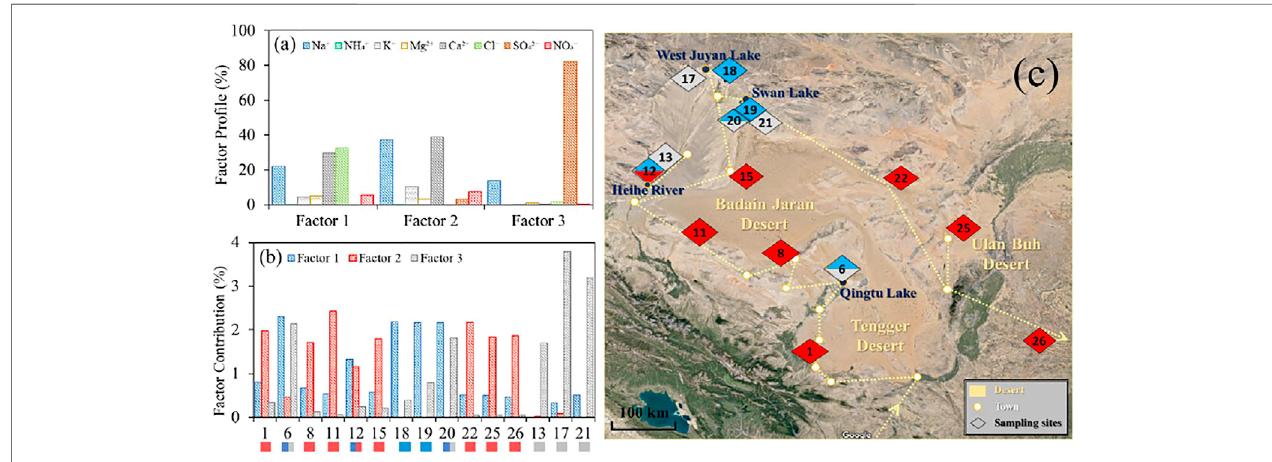
FIGURE 6 | PMF 3-factor solution based on ionic concentrations. (A) Factor pro fi le and (B) factor contribution of all samples, where the color codes below the x -axis indicate factors. (C) Sampling sites with color codes shown in map, aqueous environments marked in blue typeface. The blue code is for factor 1, the red code is for factor 2, and the grey code is for factor 3. Some samples show joint features form multiple factors.